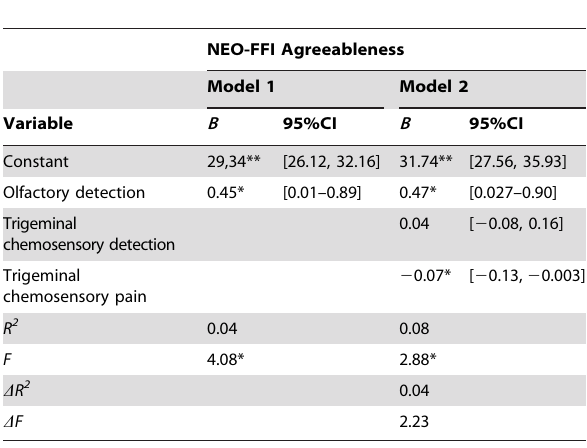
Table 3. Predictors of Agreeableness.